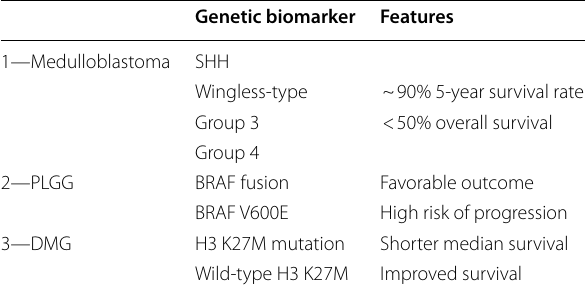
Table 3 Radiogenomic features of pediatric brain tumors